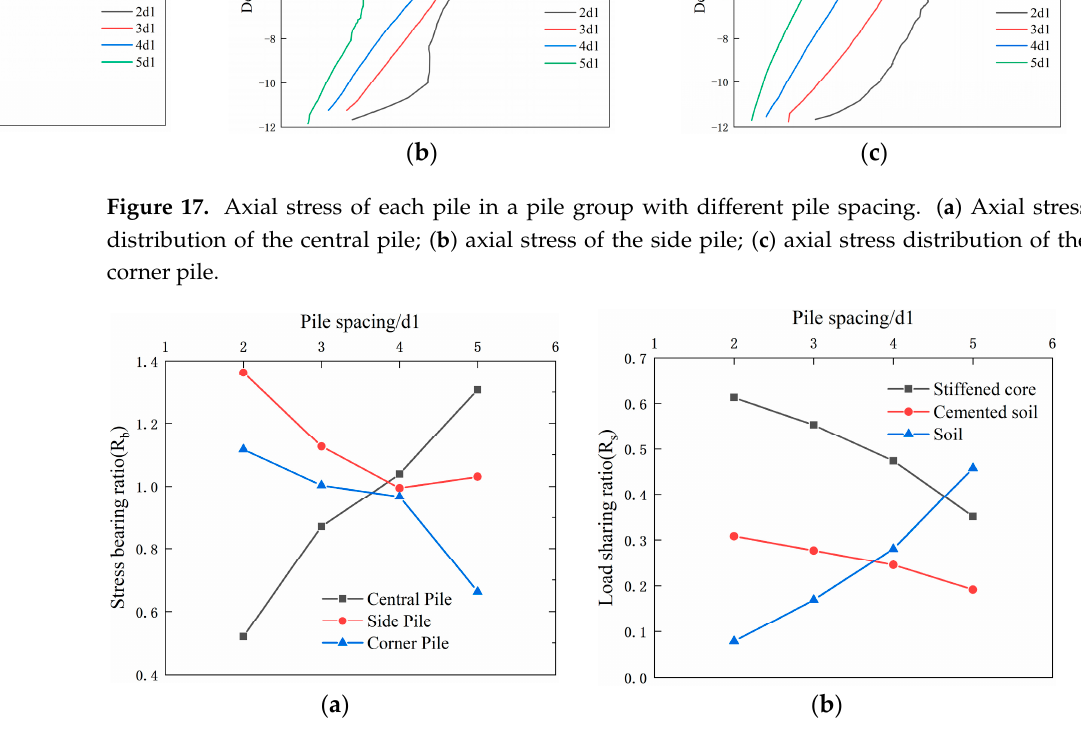
Figure 18. Each pile with different pile spacing: ( a ) variation of stress-bearing ratio, R b ; ( b ) pile-soil load-sharing ratio, R s .